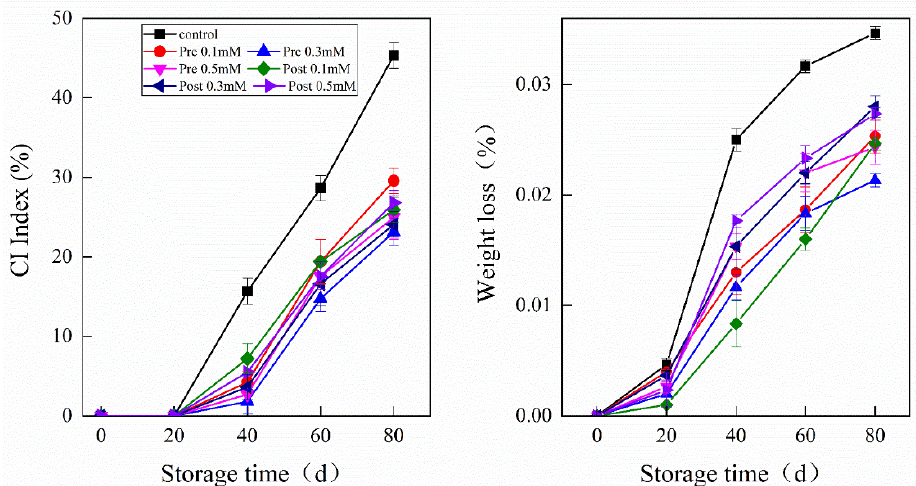
Figure 2. Effect of pre-harvest (Pre) and post-harvest (Post) MeJA treatments on weight loss in lemons at storage at 7 − 10 ◦ C. Data are the mean ± SE of three replicates of five fruit.